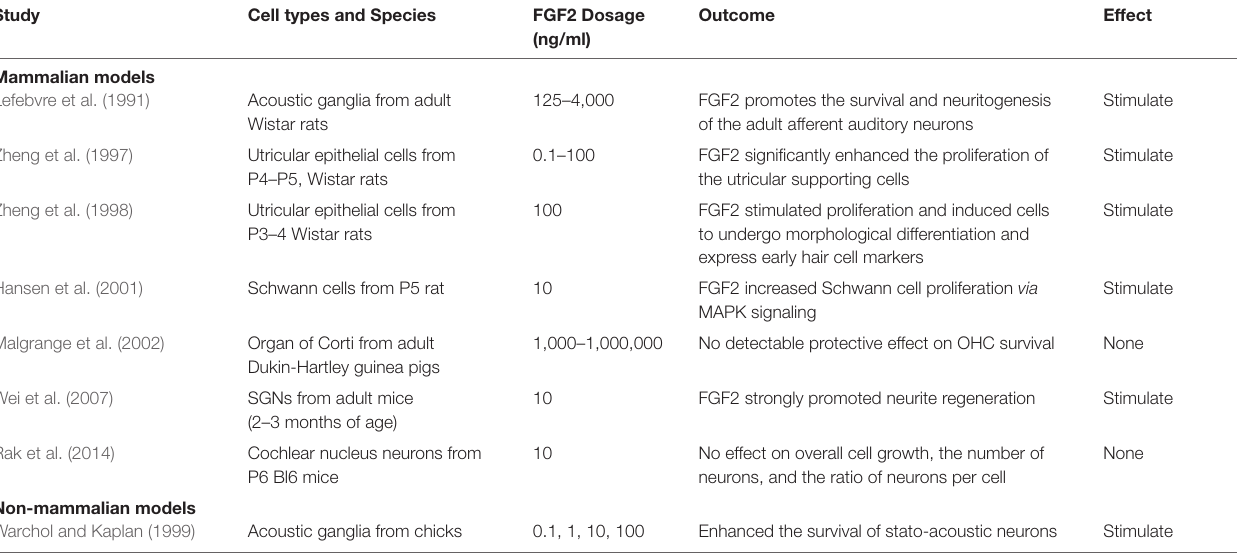
TABLE 2 | In vitro studies of FGF2 in sensory and neural cell survival, proliferation, and